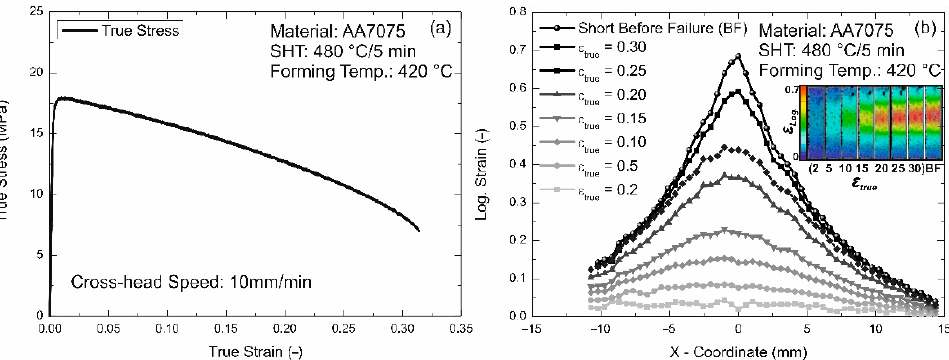
Figure 2. ( a ) Hot forming behavior of AA7075 at 420 °C after solution heat treatment and the cor- responding ( b ) evolution of local deformation along the sample surface up to short before failure